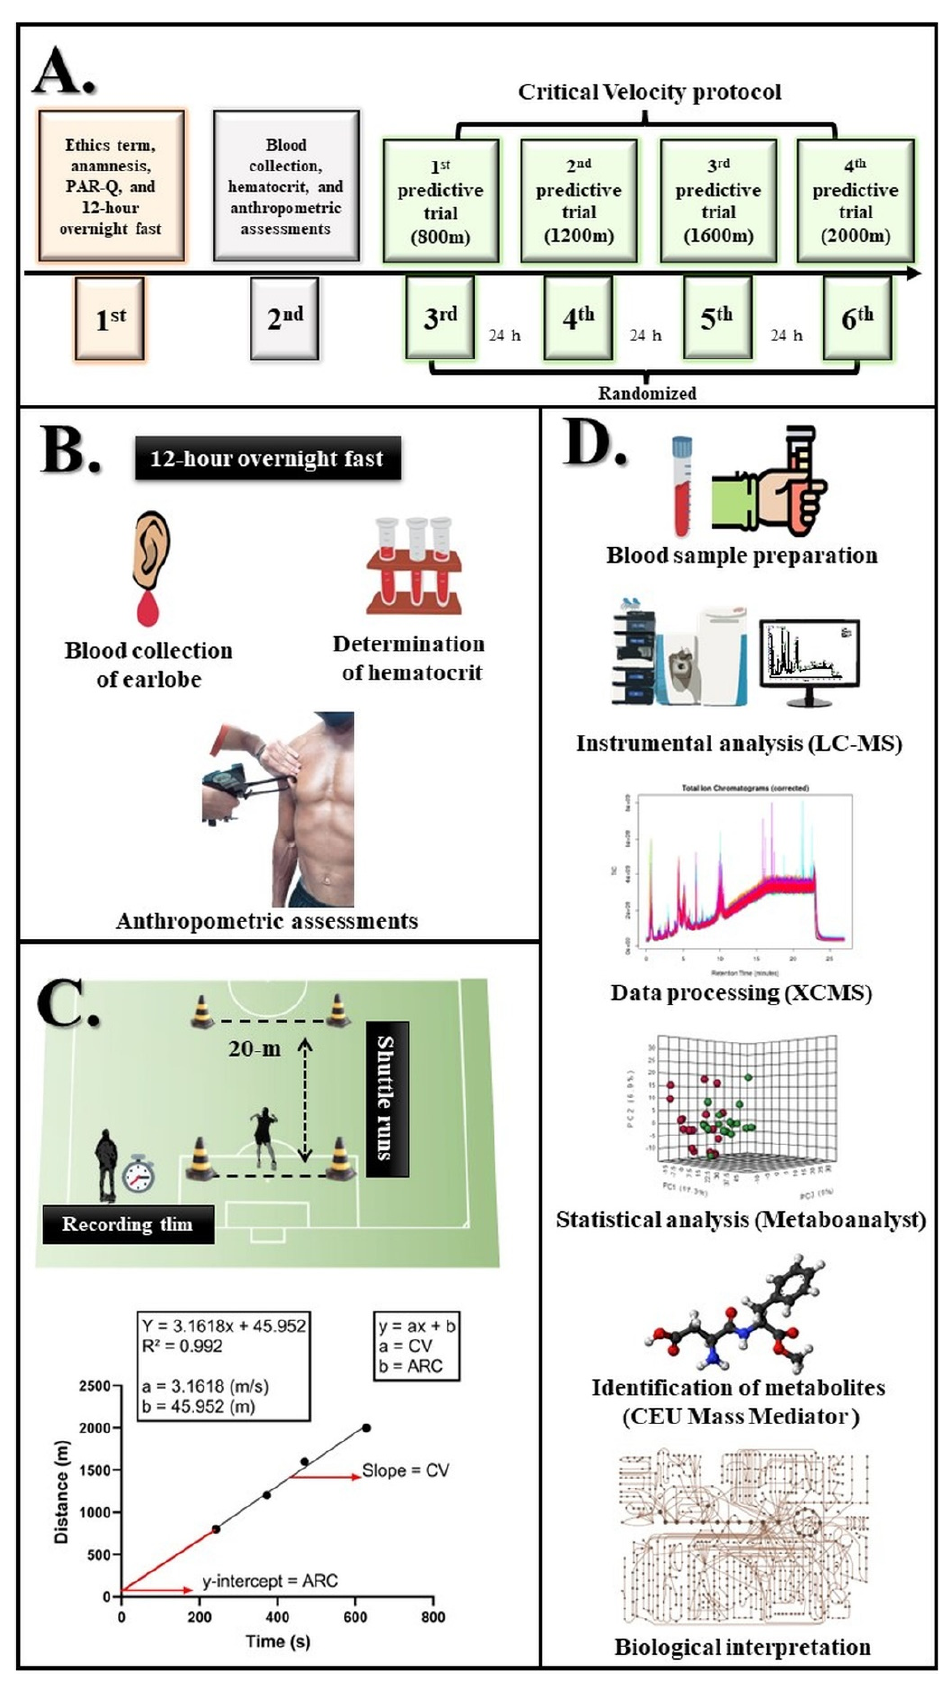
Figure 1. ( A ) shows the experimental design used in the study. ( B ) exemplifies blood sample collec- tion after an overnight fast for metabolomic analysis and volume determination of red blood cells